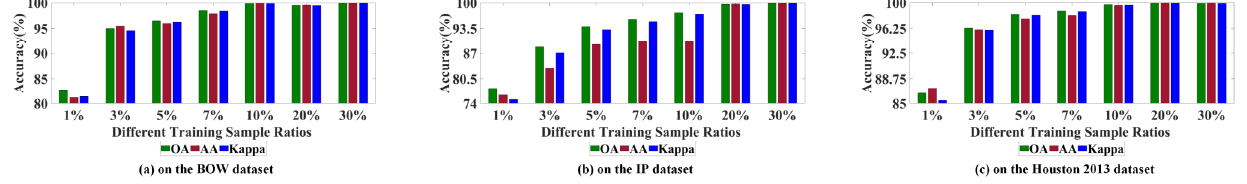
Figure 9. The classification results of diverse training ratios.